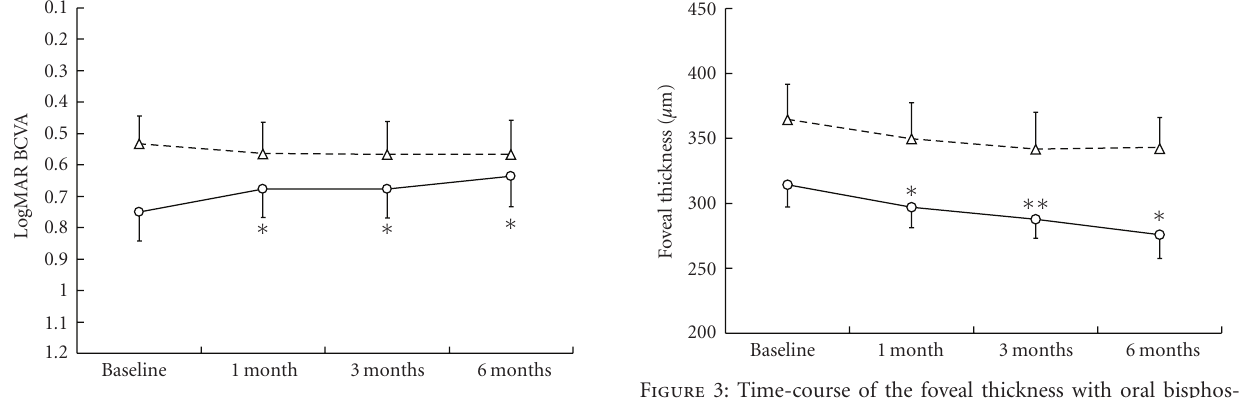
Figure 1: Time-course of the LogMAR BCVA values with oral bisphosphonates. Solid line; AMD, dashed line; myopic CNV. The values are presented as means + SEM. ∗ P < . 05. LogMAR: logarithm of the minimum angle of resolution, BCVA: best-corrected visual acuity.